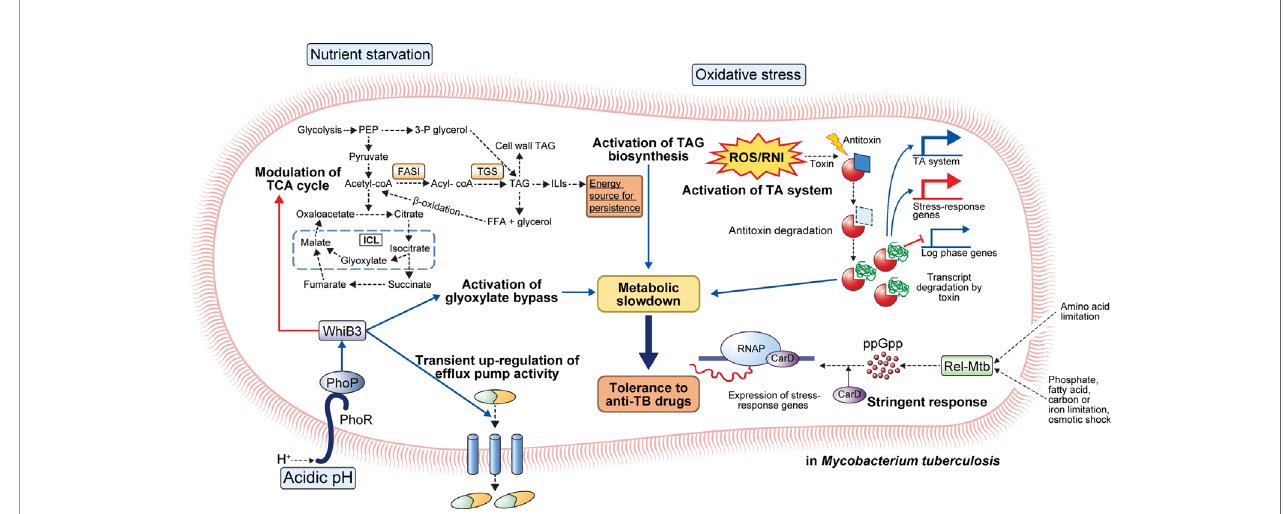
FIGURE 1 | General mechanisms for the establishment of antibiotic tolerance in Mycobacterium tuberculosis . Under host-mediated stresses, M. tuberculosis (Mtb) adapts to stress conditions via several mechanisms. Under acidic pH, the phoPR two-component system activates transcriptional regulator whiB3 that promotes suppression of the TCA cycle, activation of glyoxylate bypass, and transient upregulation of ef fl ux pump activity. Activation of glyoxylate bypass is mediated by isocitrate lyase that converts isocitrate to glyoxylate under stress conditions. Nutrient starvation induces several changes in Mtb metabolism. Nutrient starvation also suppresses the TCA cycle and activates glyoxylate bypass, thereby enhancing the accumulation of triacylglycerol (TAG). The accumulated TAG is stored in the form of intracellular lipophilic inclusions (ILIs). The stored ILIs are used as an energy source in the persistence state. Additionally, the limitation of amino acids, phosphate, fatty acids, carbon, iron, and osmotic shock induces activation of stringent response through the production of ppGpp by Rel-Mtb. Production of ppGpp activates the expression of stress-response genes that causes a metabolic slowdown. Oxidative stress induces the activation of the TA system. Degradation of antitoxin occurs, and toxin degrades the transcript of log-phase genes. Further, upregulation of stress-response genes occurs, facilitating adaptation to stress conditions. Collectively, the adaptation of Mtb to stress conditions leads to metabolic modulation that results in antibiotic